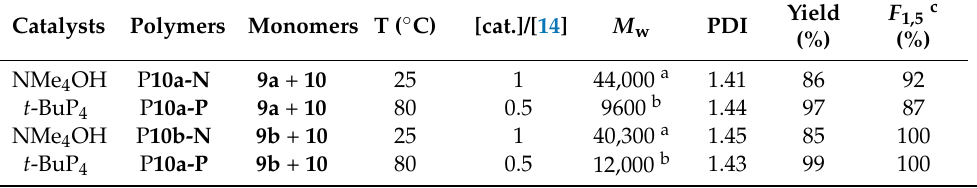
Table 1. Different performances of polymerizations with different